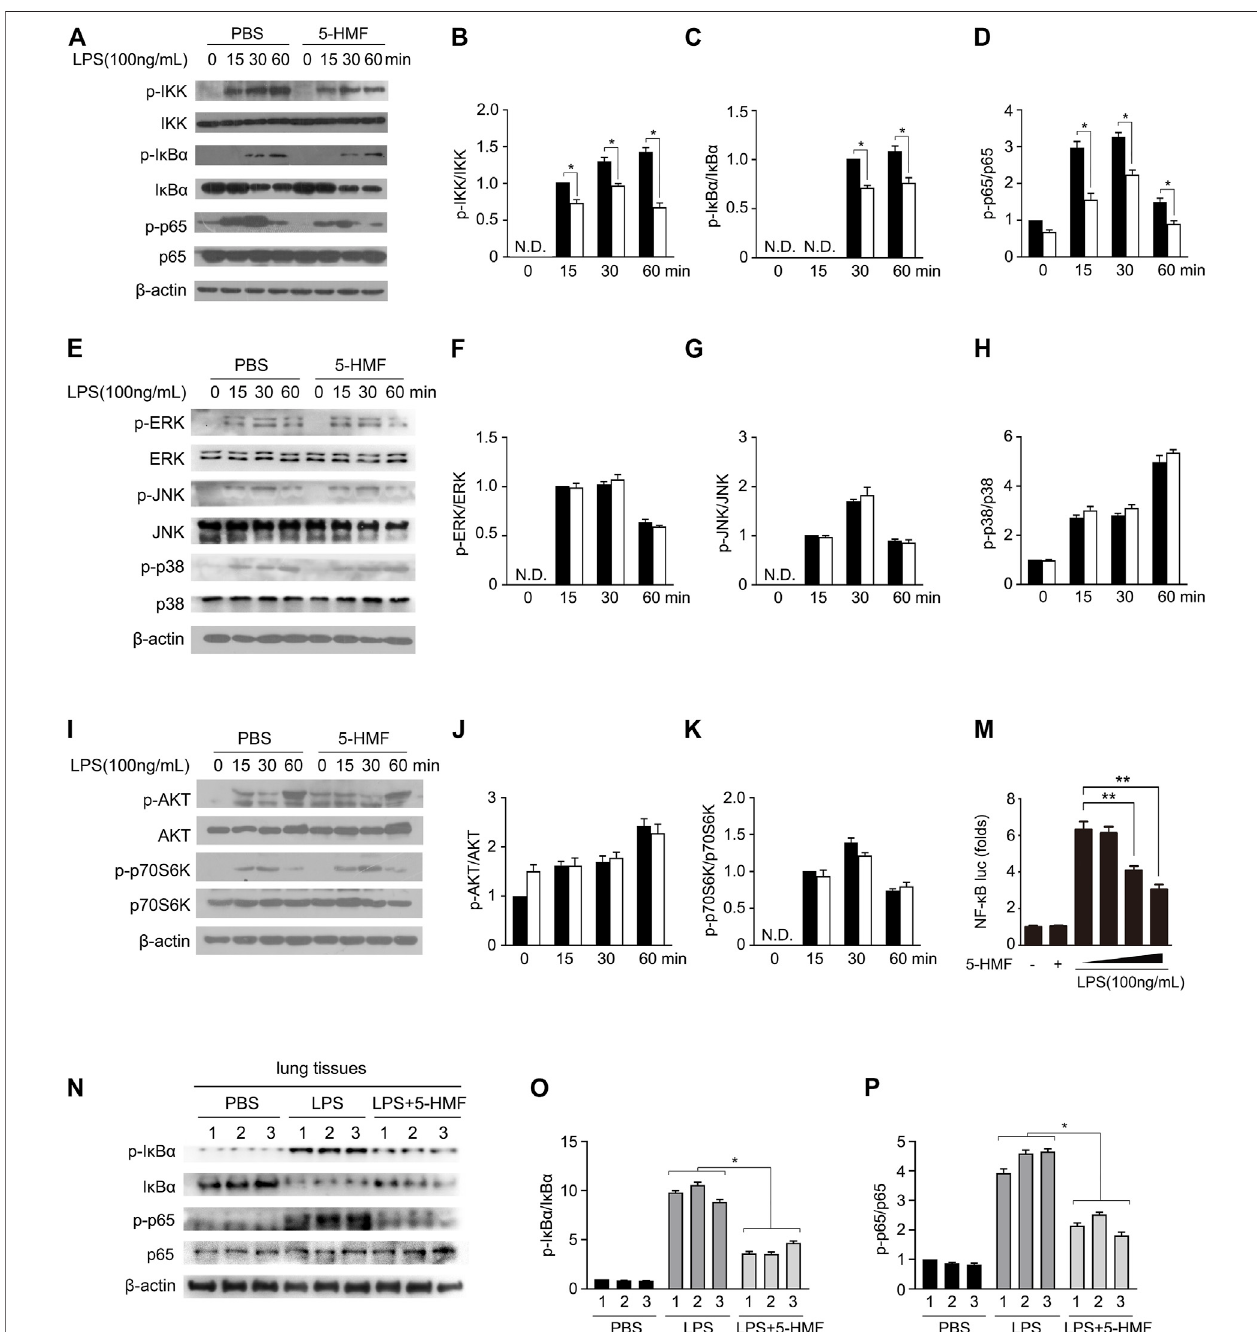
FIGURE 3 | 5-HMF inhibits NF- κ B signaling pathway. (A – K) BMDMs pretreated with PBS or 5-HMF (50 μ g/ml) were subsequently challenged by LPS for varying durations. (A – D) Immunoblot showing the expression levels of total and phosphorylated IKK, I κ B α and p65 proteins (A) . (B – D) The relative band densities of the phosphorylation ofIKK (B) , I κ B α (C) and p65 (D) were measured by ImageJ software, N.D. means non-detected. (E – H) Immunoblot showing total and phosphorylated ERK, JNK and p38 proteins (E) . (F – H) The relative band densities of the phosphorylation of ERK (F) , JNK (G) and p38 (H) . (I – K) Immunoblot showing total and phosphorylatedAKTandp70S6Kproteins (I) . (J,K) TherelativebanddensitiesofthephosphorylationofAKT (J) andp70S6K (H) . (M) RAW264.7cellstransfectedwith pGL3-NF- κ B were pretreated with PBS or different concentrations of 5-HMF as indicated, and stimulated with LPS for 6 h. Luciferase activity of the NF- κ B-driven promoter in the indicated groups. (N – P) Immunoblot showing total and phosphorylated IKK, I κ B α and p65 in the lung tissues of mice treated as in Figure 1A N . (O,P) The relative band densitiesof the phosphorylation of I κ B α (O) and p65 (P) . Data are the mean ± SD of three independentexperiments: * and ** indicate p < 0.05 and p < 0.01 respectively by Student ’ s